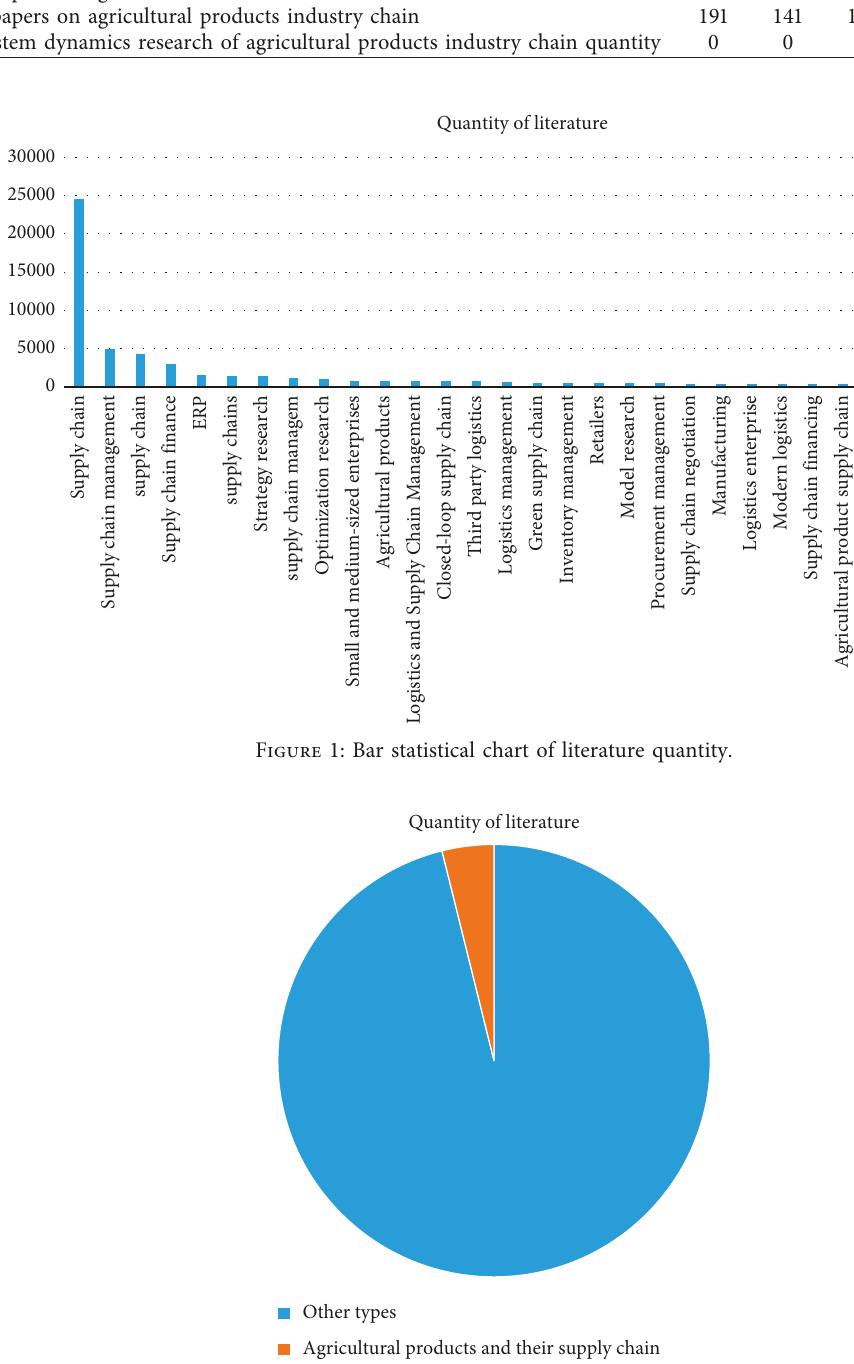
Figure 2: Sector statistical chart of literature